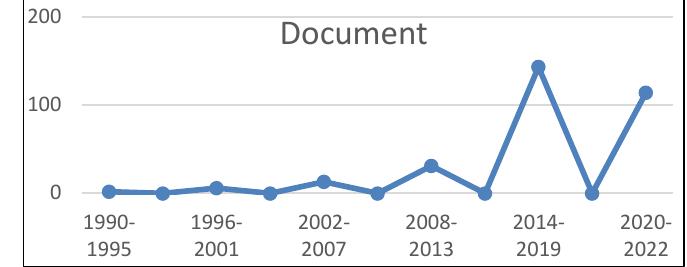
Figure 1: Publication per year.